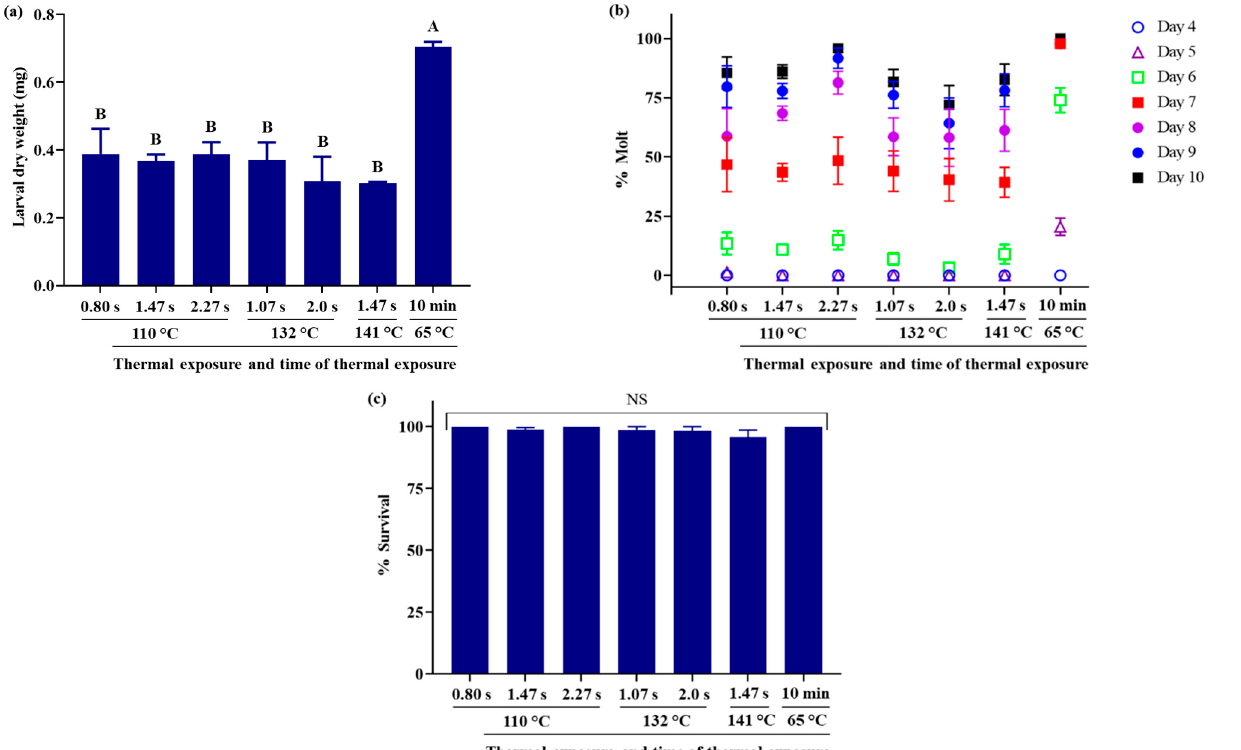
Figure 2. Effects of high thermal exposure (110–141 °C) and short time intervals of thermal exposure (0.8–2.3 s): dry weight ( a ), percent successful completion of molt to 2nd instar ( b ), and percent survival ( c ). Western corn rootworm larvae were reared on WCRMO-2 diet for 10 days. Means with bars followed by different letters are significantly different ( p < 0.05). Means ± SEM.